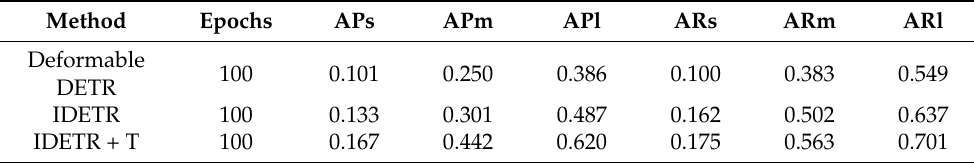
Table 2. Comparison of results of algorithm metrics.